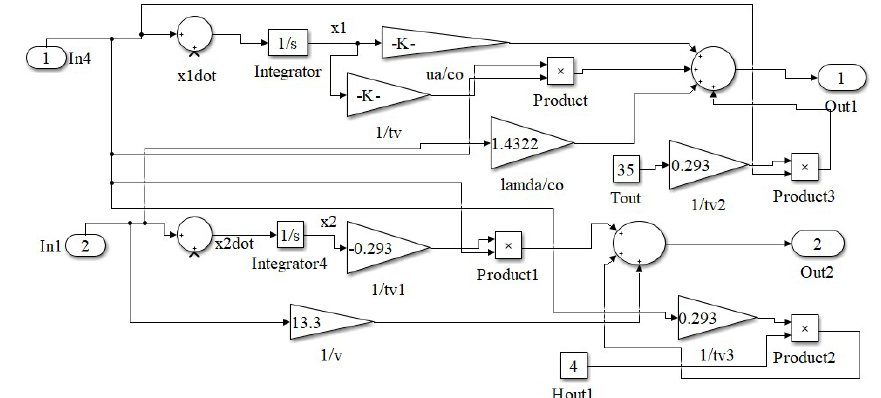
Figure 3. Dynamic Modeling of Greenhouse Model.